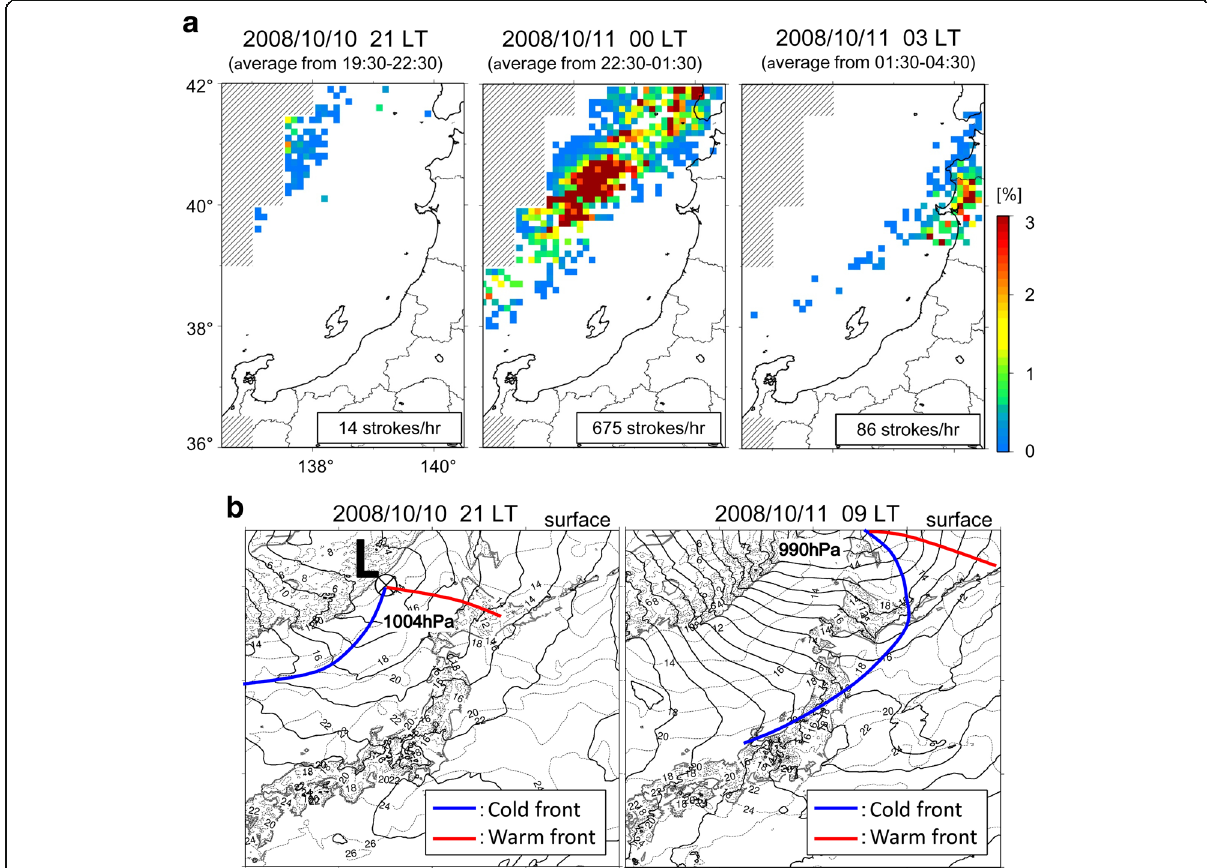
Fig. 10 Lightning frequency distributions and atmospheric conditions at the surface for case A. a Time series maps of lightning frequency distribution. The lightning frequency on the map is an hourly average calculated in a 3 h time window around the reference time. b Sea-level pressure ( solid lines ) and surface air temperature ( broken lines ) distributions obtained by MSM-GPV. Contour interval of sea-level pressure is 4 hPa. “ L ” represents the center of the cyclone defined as the point at which sea-level pressure is the lowest. Locations of cold/warm fronts are